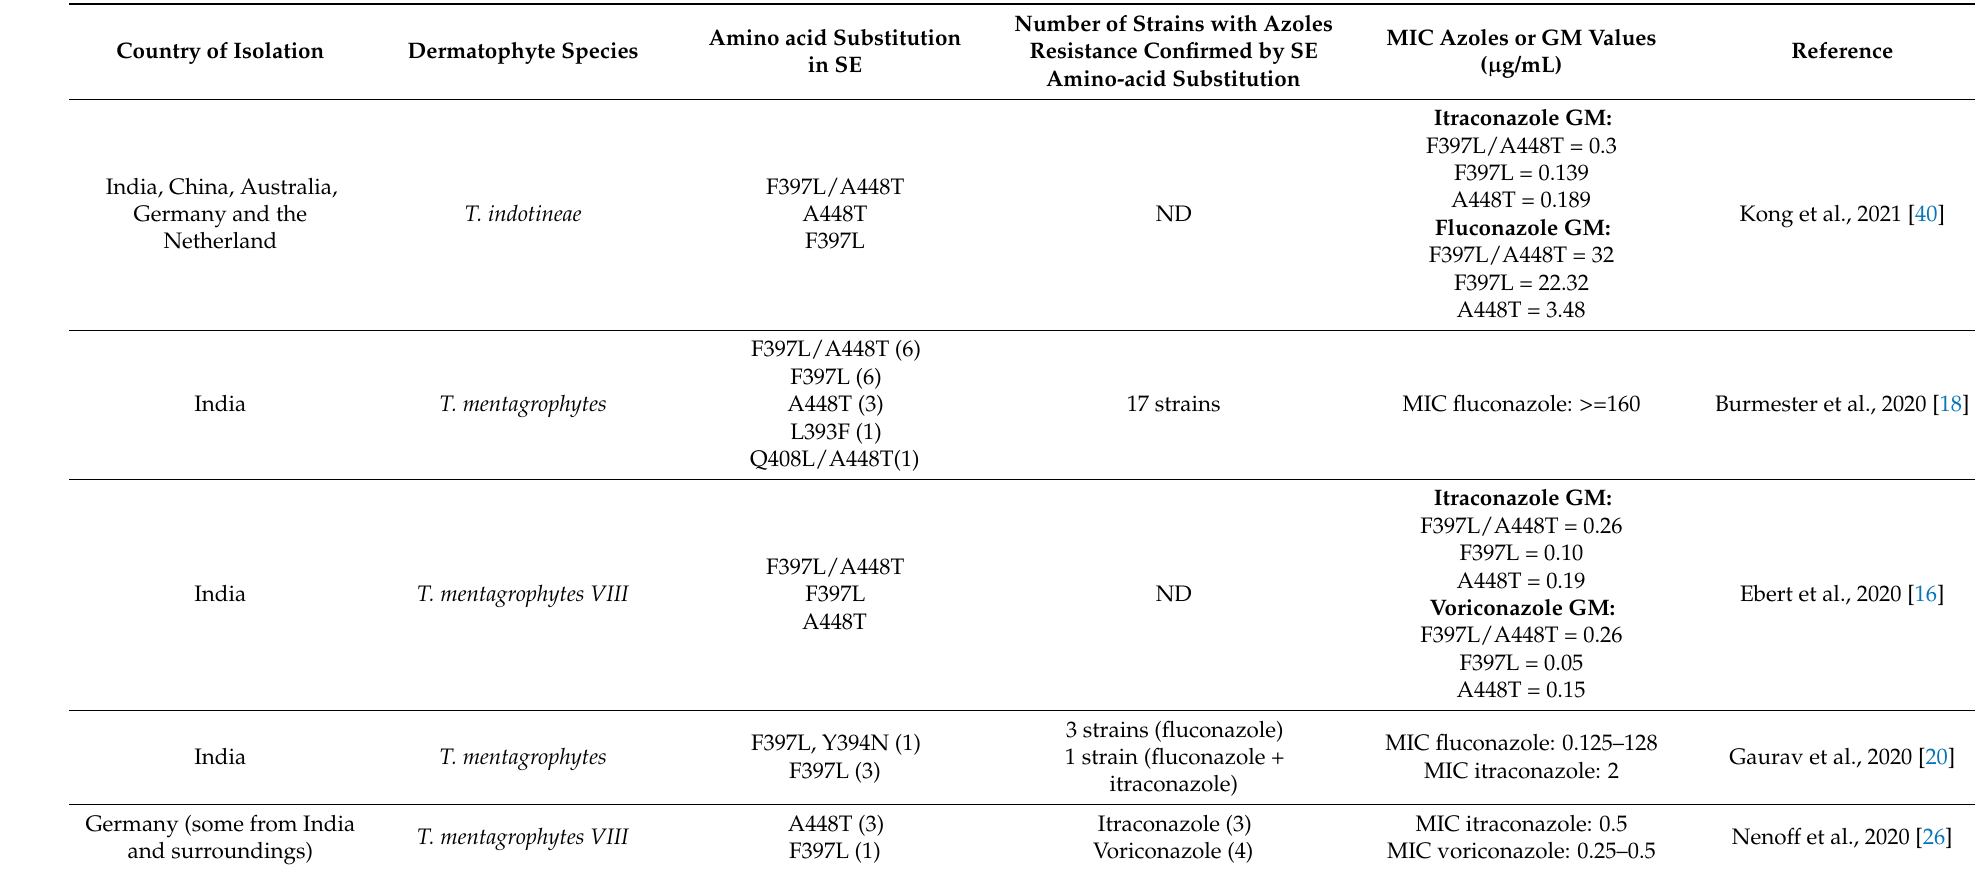
Table 4. Summary of amino acid substitutions in SE and MICs values observed in azoles resistant strains isolated in previous studies. ND = not determined, GM geometric mean, MIC =minimum inhibitory concentration, SE = squalene